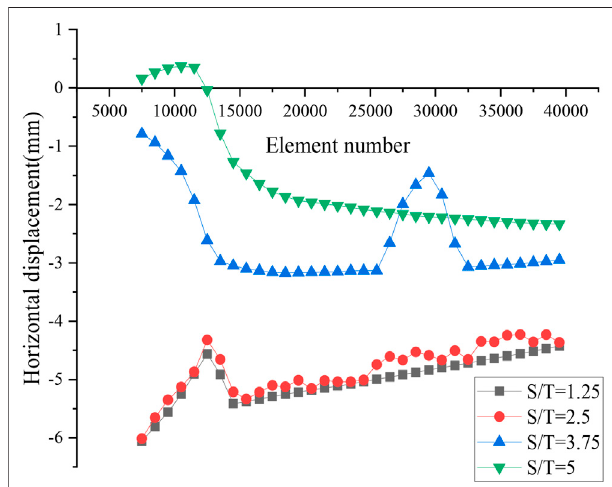
FIGURE 17 | Multielement displacement